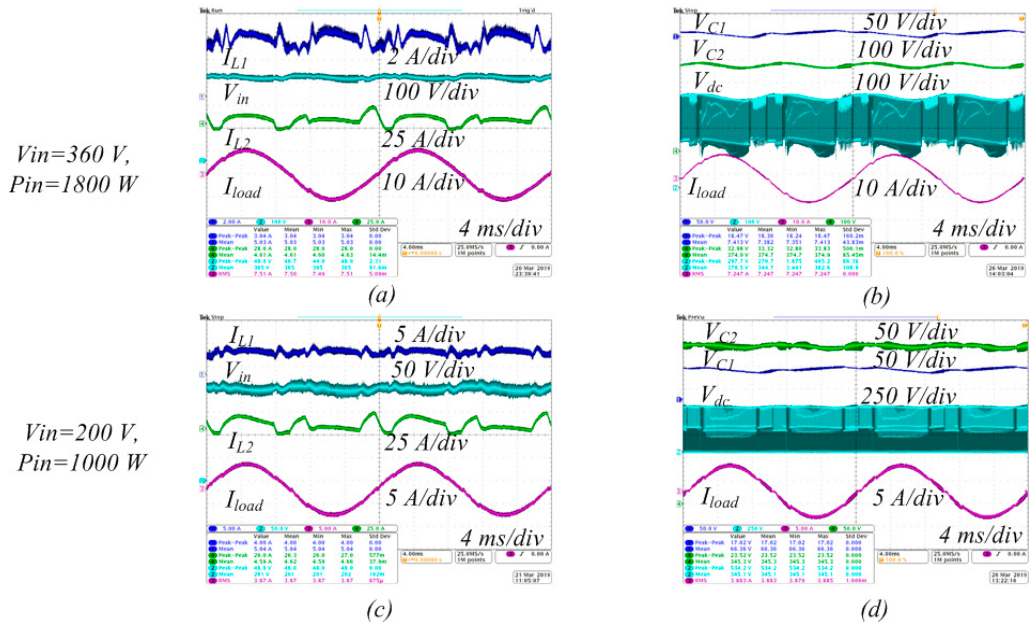
Figure 7. Operation waveforms of 3L NPC QZSI at a nominal power level of 1800 W ( a , b ) and in boost voltage mode at a reduced power level of 1000 W ( c , d ).